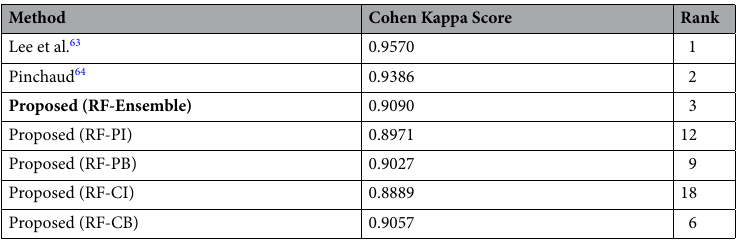
Table 6. Comparison of the proposed with other published approaches for automated pN-Staging in CAMELYON17 challenge. The score reported in the table is from the open public leader board of the CAMELYON17 challenge. The proposed approach (RF-Ensemble) stood rank-3 on the leaderboard (Accessed on 31-Dec-2019). The table additionally provides the performance of individual Random Forest classifiers in the ensemble and RF-Ensemble classifier.